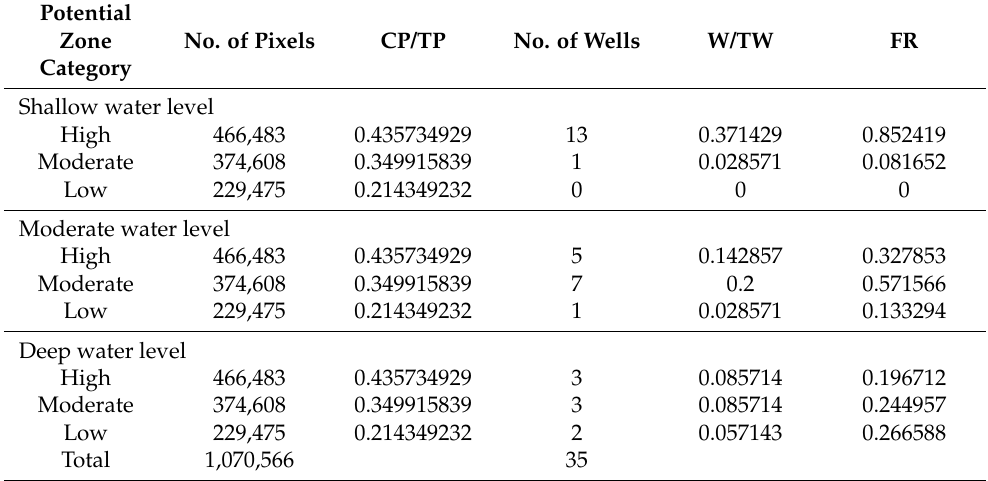
Table 5. Frequency ratio between water level and surface parameter-based groundwater potential